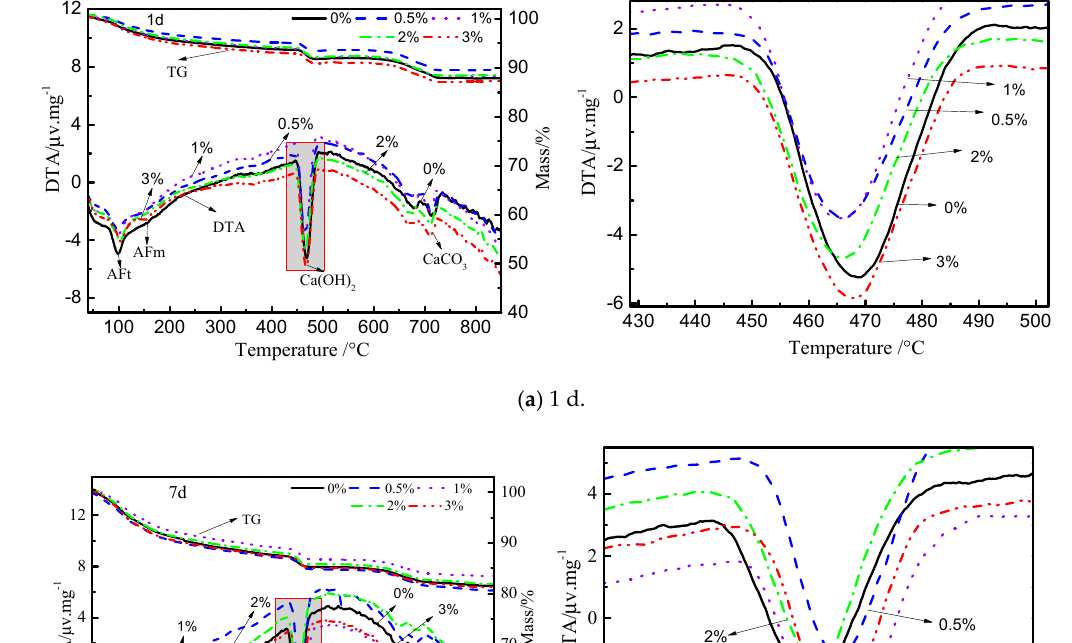
Table 4 . The Weight Loss of Ca(OH) 2 at Different Ages.